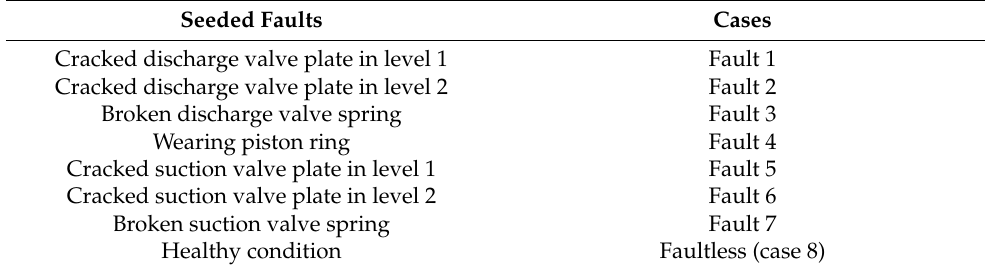
Table 3. Seeded fault